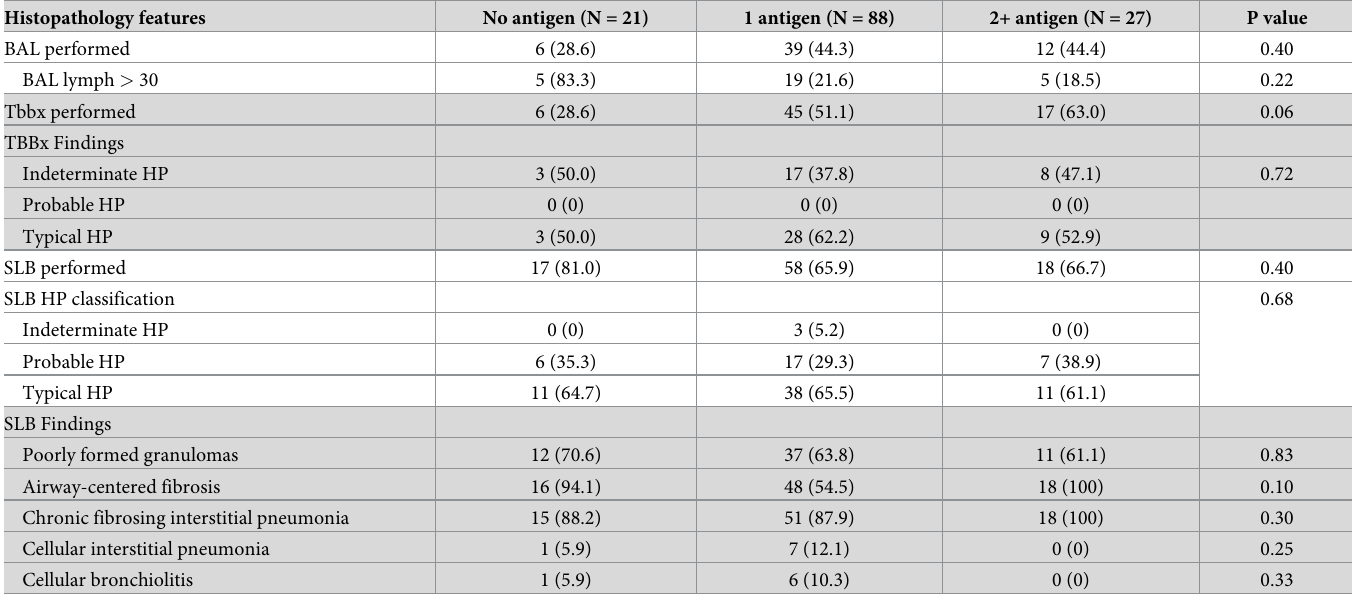
Table 4. Transbronchial biopsy and SLB characteristics of retrospective cohort.